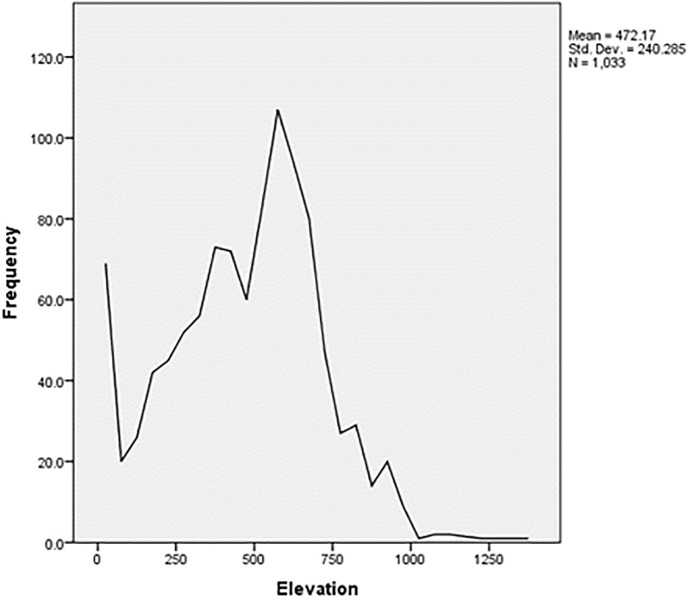
Frequency of Dubas bug infestations and elevation (Esri ArcGIS 10.3).